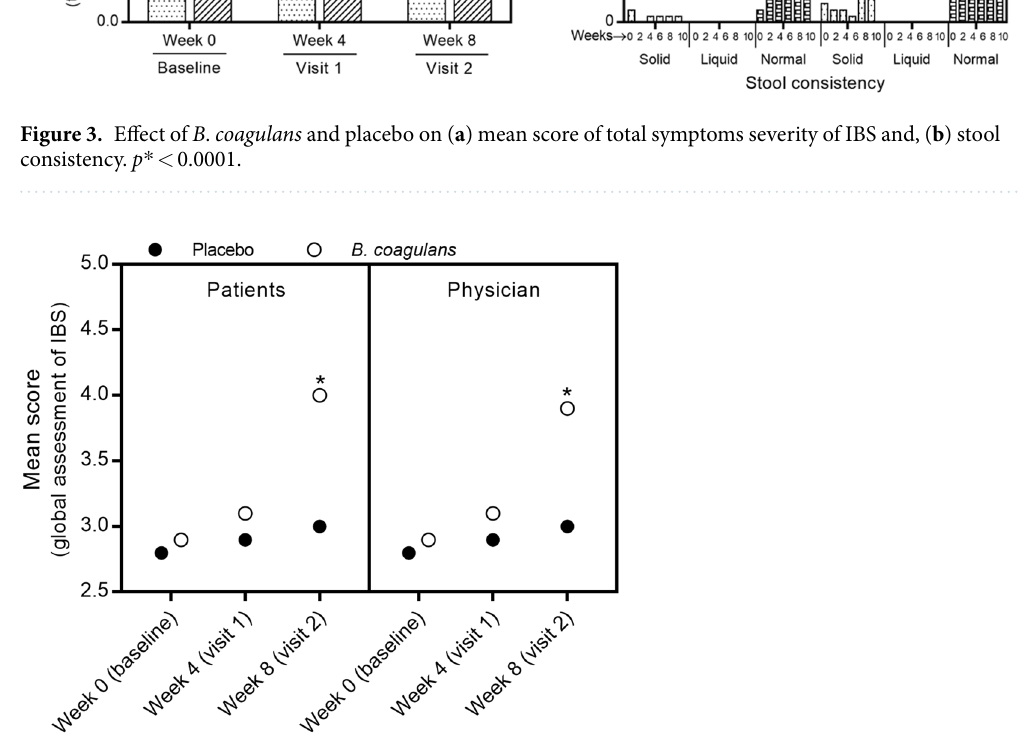
Figure 4. Effect of B . coagulans and placebo on patients and physician global assessment of IBS. Results are reported on 1–5 scale. p * <